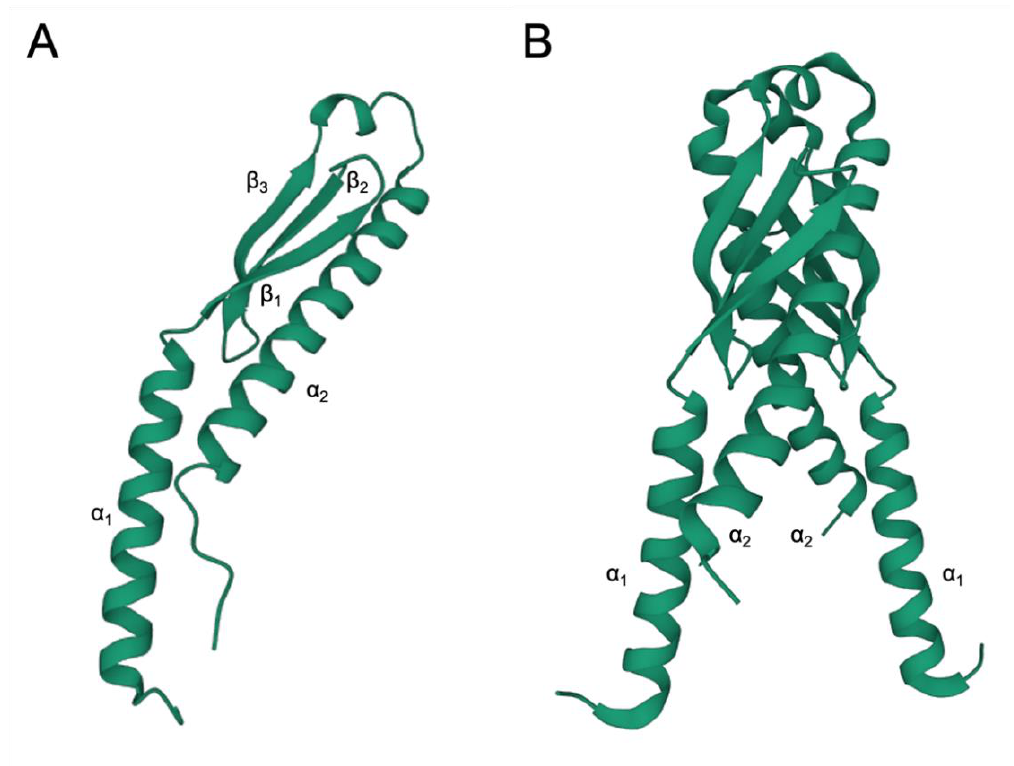
Figure 4. Canonical structure of EbfC/YbaB: ( A ) ribbon diagram of YbaB monomer highlighting the α + β structure with the topology N- α 1/ β 1/ β 2/ β 3/ α 2-C; ( B ) ribbon diagram of the dimer, which is the most observed functional structure [33]. Structures were predicted using AlphaFold [50] and visualised using Mol*Viewer [51].